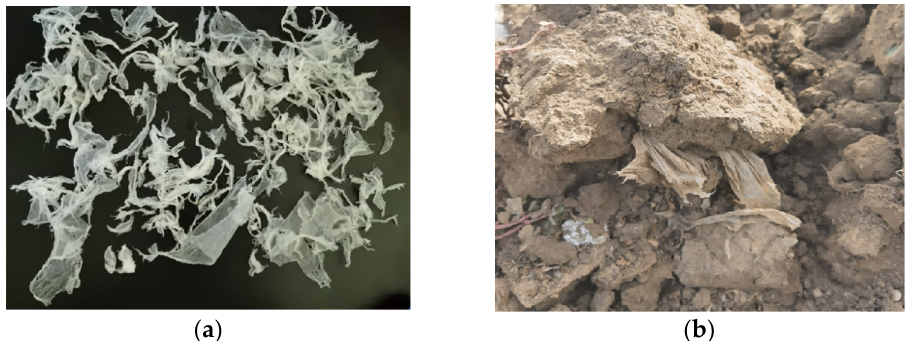
Figure 2. Morphological characteristics of residual film. ( a ) Distribution pattern of residual membrane; ( b ) Main forms of residual film in soil.